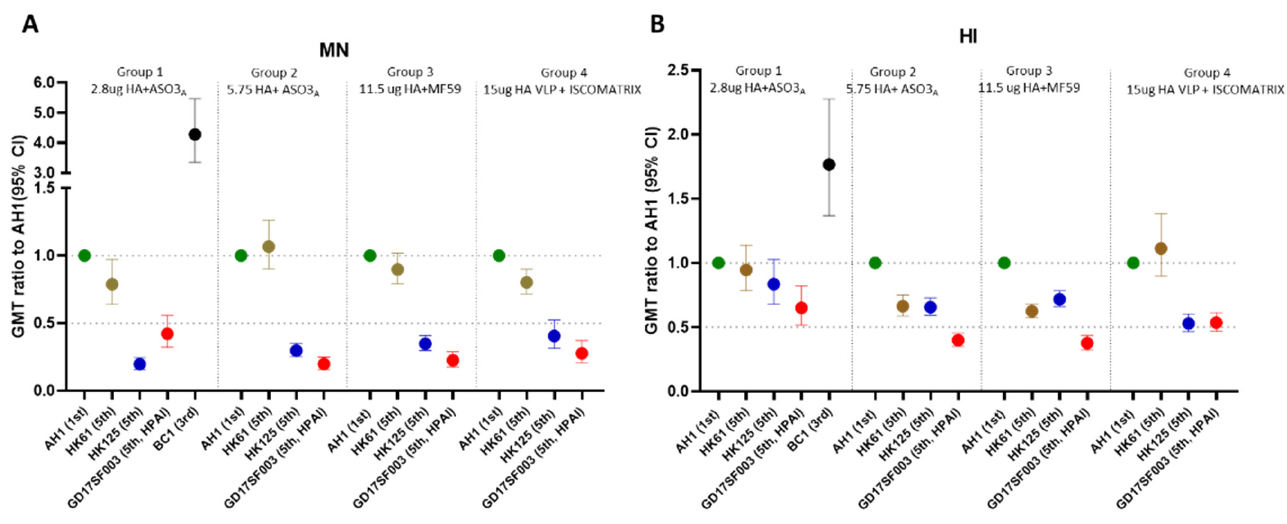
Figure 2. Post-vaccination GMT ratios of the heterologous MN and HI responses from the 3rd and 5th wave viruses compared to the 1st wave homologous A(H7N9) wild type vaccine viruses. Time points shown are 21–28 days post-2nd dose. GMT ratios were calculated as “post-vaccination GMT to the heterologous virus/post-vaccination GMT to the homologous vaccine virus”. ( A ) MN GMT ratios; ( B ) HI GMT ratios in 4 vaccine groups. GMT ratios with 95% confidence interval (95% CI) per vaccine group are shown